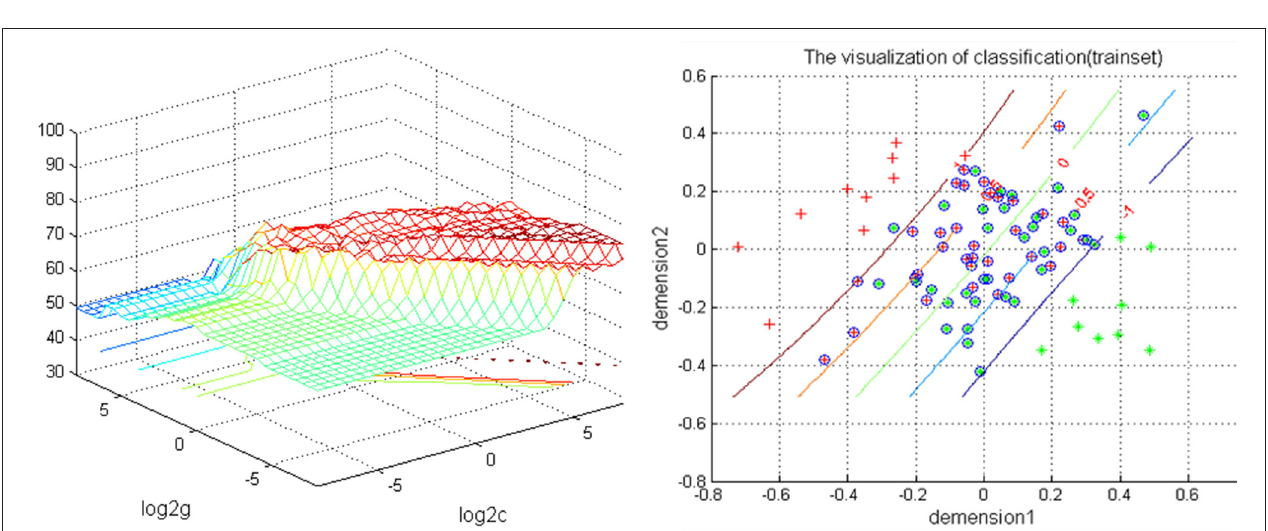
FIGURE 2 | Depiction of classifications based on the SVM using a combination of NH values in the bilateral PCu to differentiate rTLE patients from HCs. Left: SVM parameters result of 3D view. g means gamma, c means penalty coefficient. Right: dimension 1 and dimension 2 represent the NH values in the bilateral PCu. Green crosses represent rTLE patients, and the red crosses represent HCs. SVM, support vector machine; NH, network homogeneity; PCu, precuneus; rTLE, right temporal lobe epilepsy; HCs, healthy